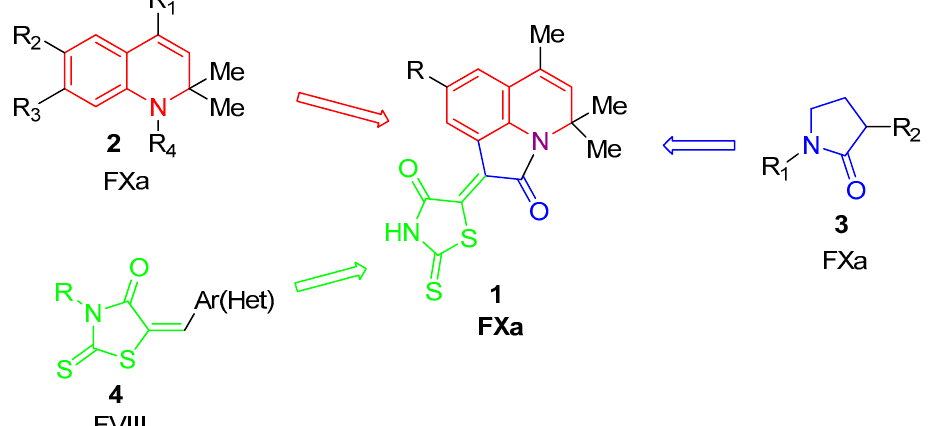
Figure 3. An example of the molecular hybridization strategy. Structure of hybrid FXa inhibitors found in our previous study ( 1 ) and structural fragments of some known inhibitors of coagulation factors: 1,2-dihydroquinoline ( 2 ), pyrrolidinone ( 3 ), and rhodanine ( 4 ). 1,2,3,4-Tetrahydroquinolines ( 5,6 ) with phenyl and methyl substituents [18,21] as well as 1,2-dihydroquinolines containing N-acetylaminomethyl groups at C 4 ( 8 ) [22] (see Figure 4) are also